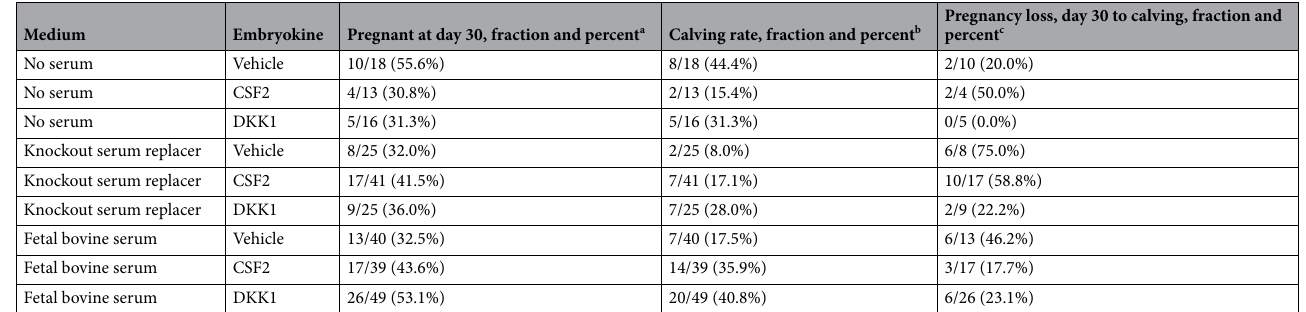
Table 2. Effect of culture medium and embryokine treatment of embryos on pregnancy outcome at day 30 of gestation and calving for one farm in which data at calving were recorded. Abbreviations are as follow: BSA bovine serum albumin, CSF2 colony stimulating factor 2, DKK1 dickopf WNT signaling pathway inhibitor- 1. a There was an interaction between no serum vs (SR + FBS) and vehicle vs DKK1 (P = 0.084). b Calving rate was affected by medium (P = 0.079). Analysis of contrasts indicated that serum replacement (SR) differed from fetal bovine serum (FBS) (P = 0.027), and there were interactions between no serum vs (SR + FBS) and vehicle vs CSF2 (P = 0.050) and no serum vs (SR + FBS) and vehicle vs DKK1 (P = 0.051). c There were no effects of medium, embryokine or the interaction (P ≥